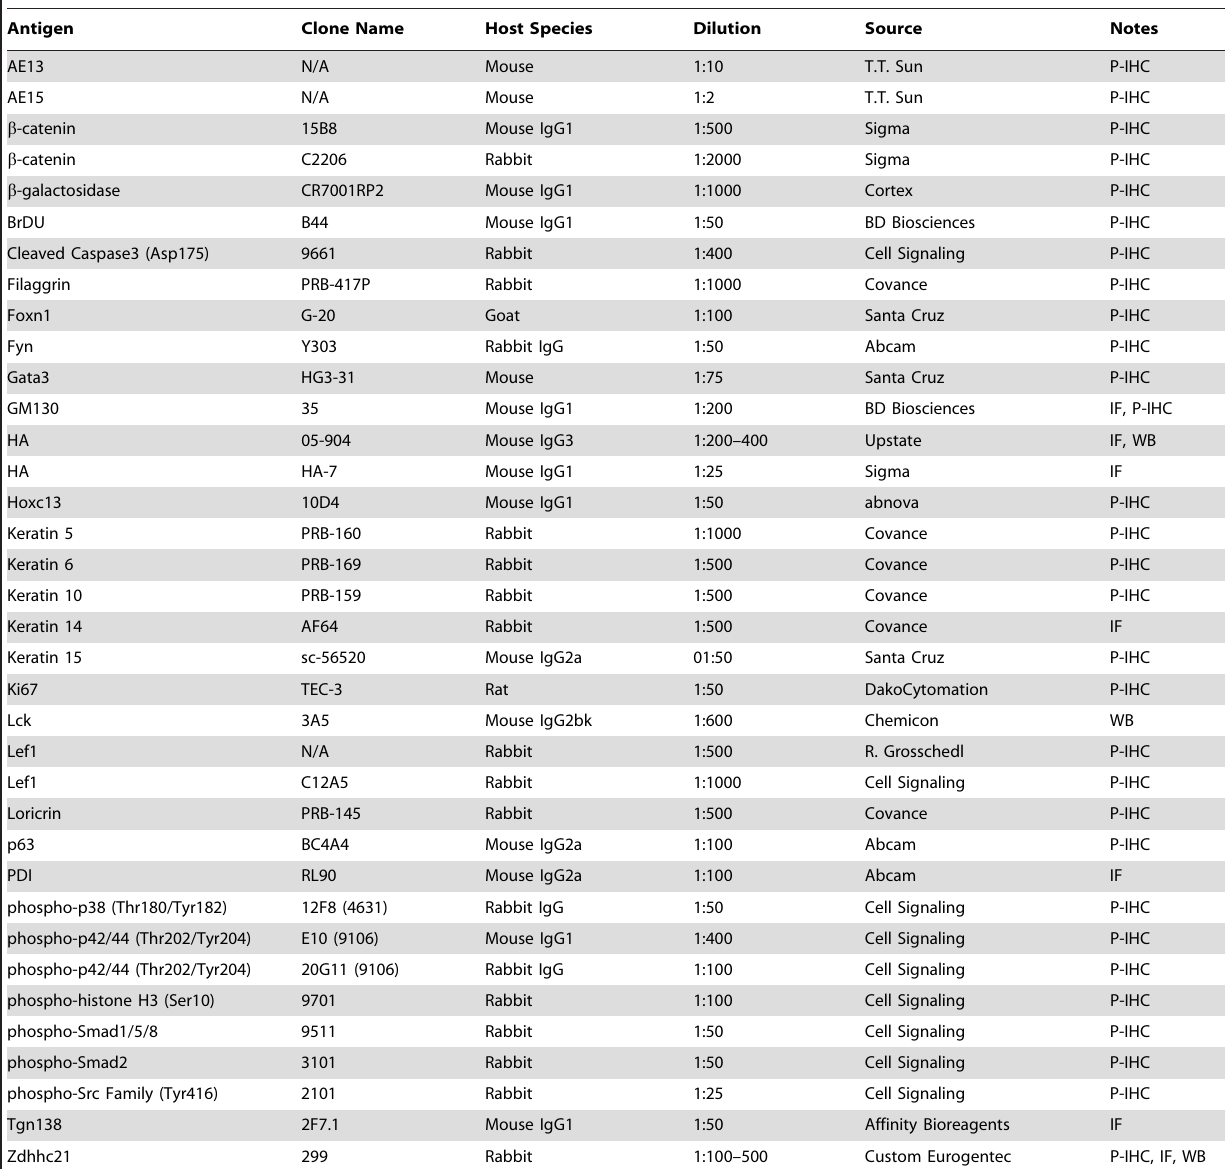
Table 1. Details of primary antibodies used in this study.